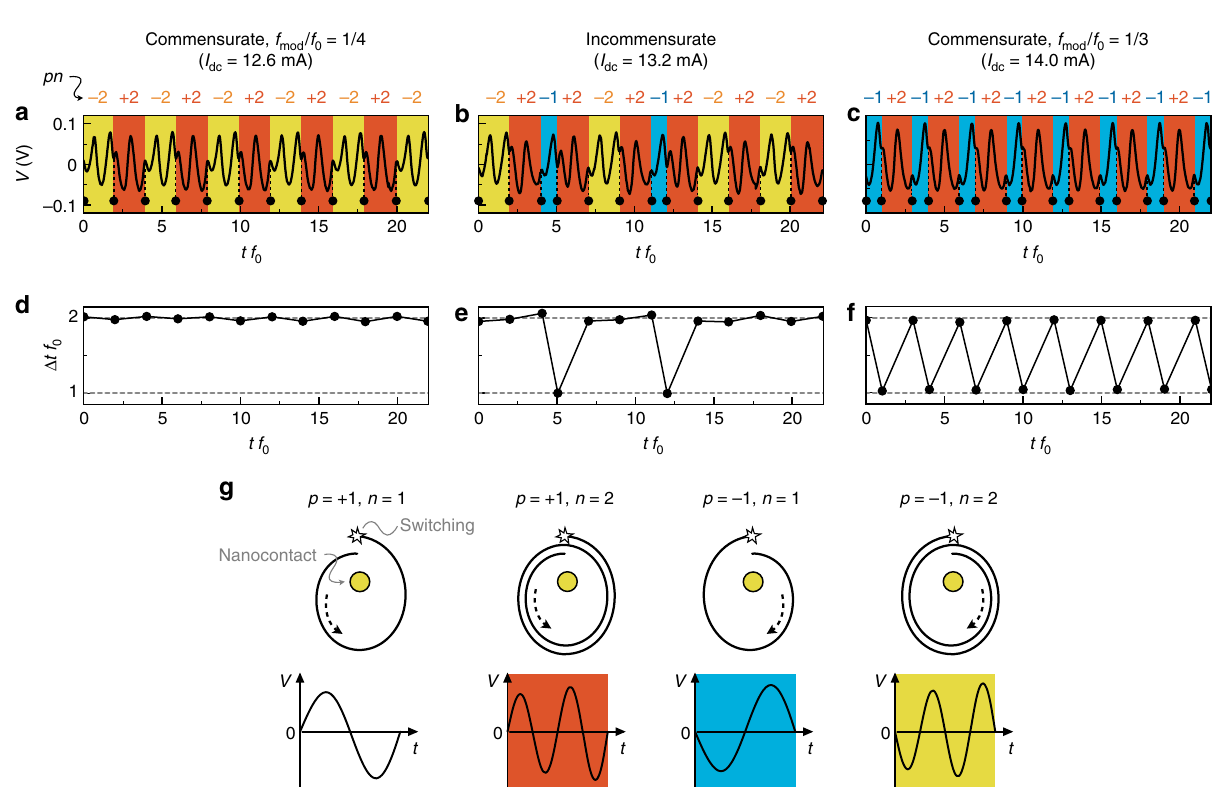
= 12.6, 13.2, and 14.0 mA. The black dots dc